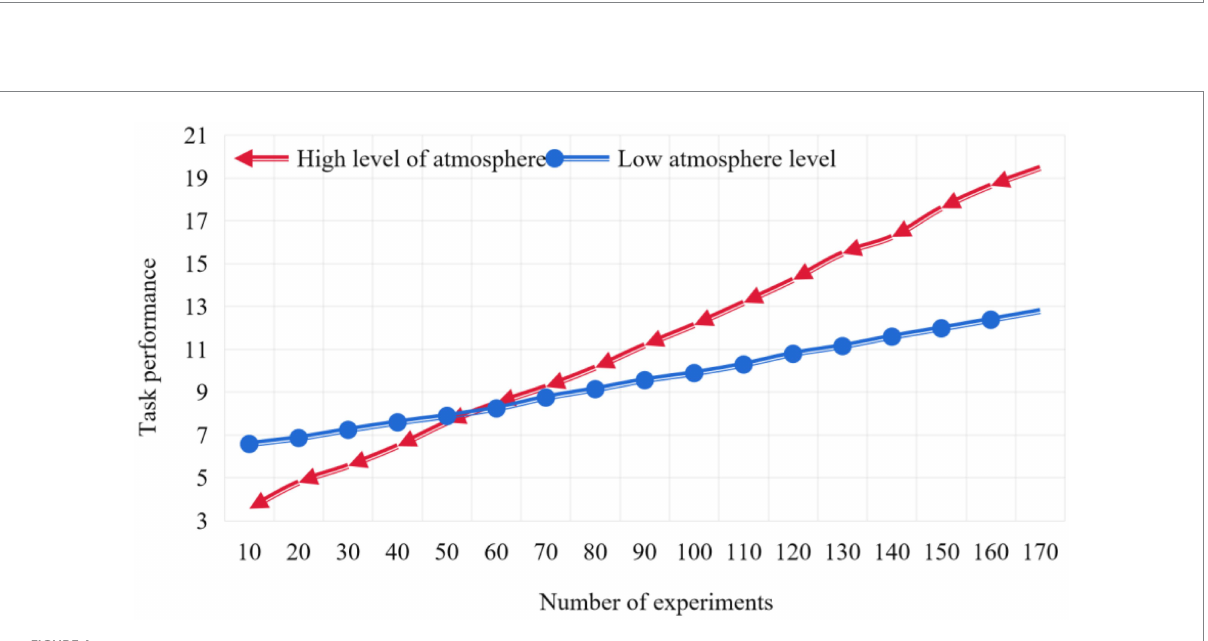
FIGURE 4 Adjustment of team open enterprise employee and team task